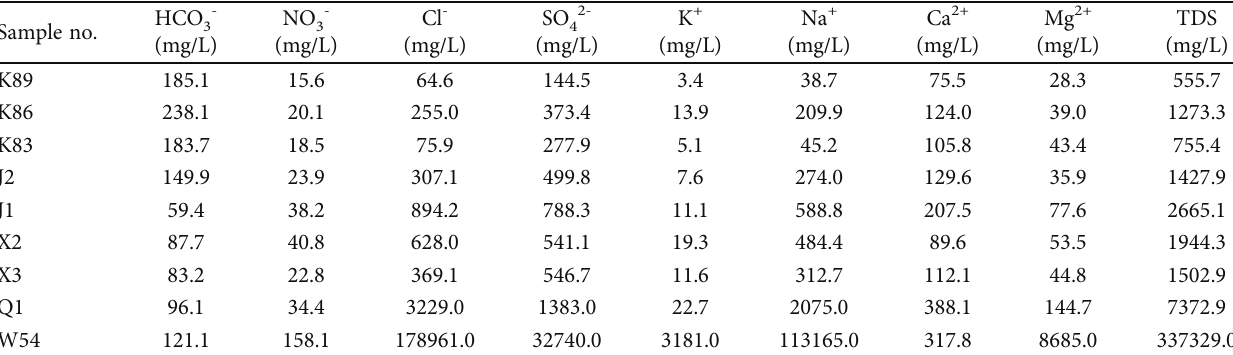
Table 2: Results of the chemical analysis of the water samples in the study area. Sample